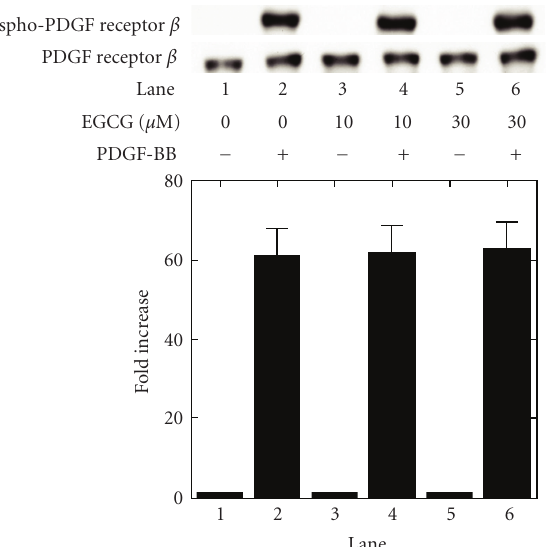
Figure 2: E ff ect of EGCG on the PDGF-BB-induced autophos- phorylation of PDGF receptor β in MC3T3-E1 cells. The cultured cells were pretreated with the indicated doses of EGCG or vehicle for 60 minutes, and then stimulated by 50 ng/mL PDGF-BB or vehicle for 3 minutes. The extracts of cells were subjected to SDS- PAGE with subsequent Western blotting analysis with antibodies against phospho-specific PDGF receptor β or PDGF receptor β . The histogram shows quantitative representations of the levels of PDGF-BB-induced autophosphorylation obtained from laser densitometric analysis of three independent experiments. Each value represents the mean ± SEM of triplicate determinations. Similar results were obtained with two additional and di ff erent cell